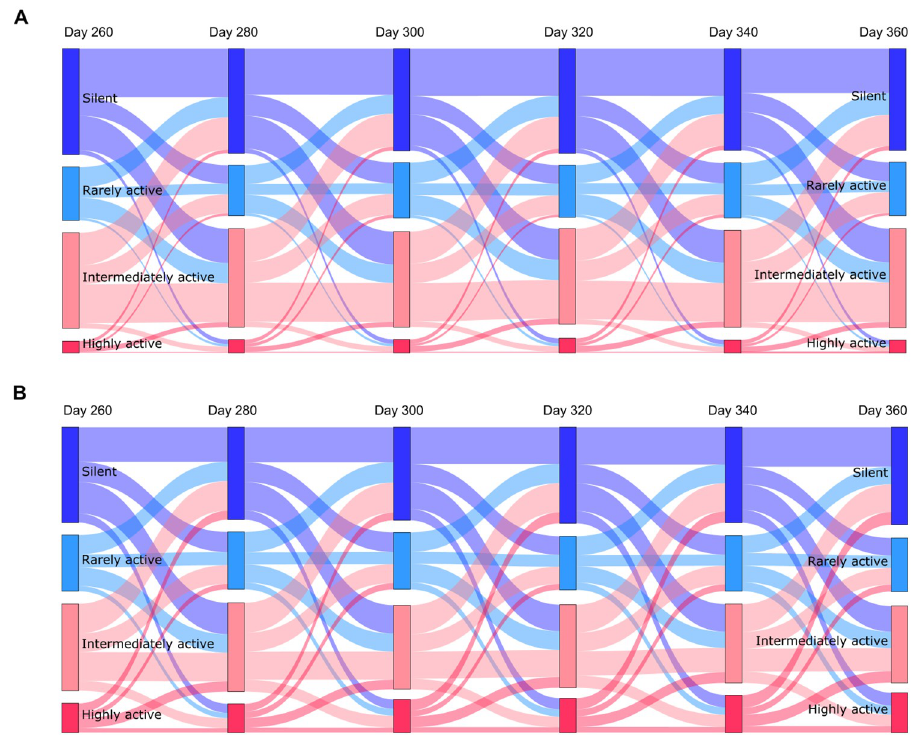
Fig 6. The proportion of highly active cells increases and firing rates are less stable in the synapse loss model. Sankey diagrams showing the proportion of cells classified by mean firing rate and flow between categories across sessions 20 days apart for the wildtype (A) and the synapse loss model (B) starting on day 260. Cells were classified as silent (mean firing rate = 0 Hz; top node in dark blue), rarely active (0 − 0.5 Hz; second node from the top in light blue), intermediately active (0.5 − 2 Hz; second node from the bottom in light pink) and highly active ( > 2 Hz; bottom node in red). The height of each node represents the proportion of cells with the given activity level out of all cells on the day specified above the nodes. The height of the links between nodes represents the proportion of cells that were part of the original node on the specified day and were part of the connected node 20 days later. For example, the top left dark blue link represents the proportion of cells that were silent on day 260 and day 280. Links are shaded in the same colour as the node they originate